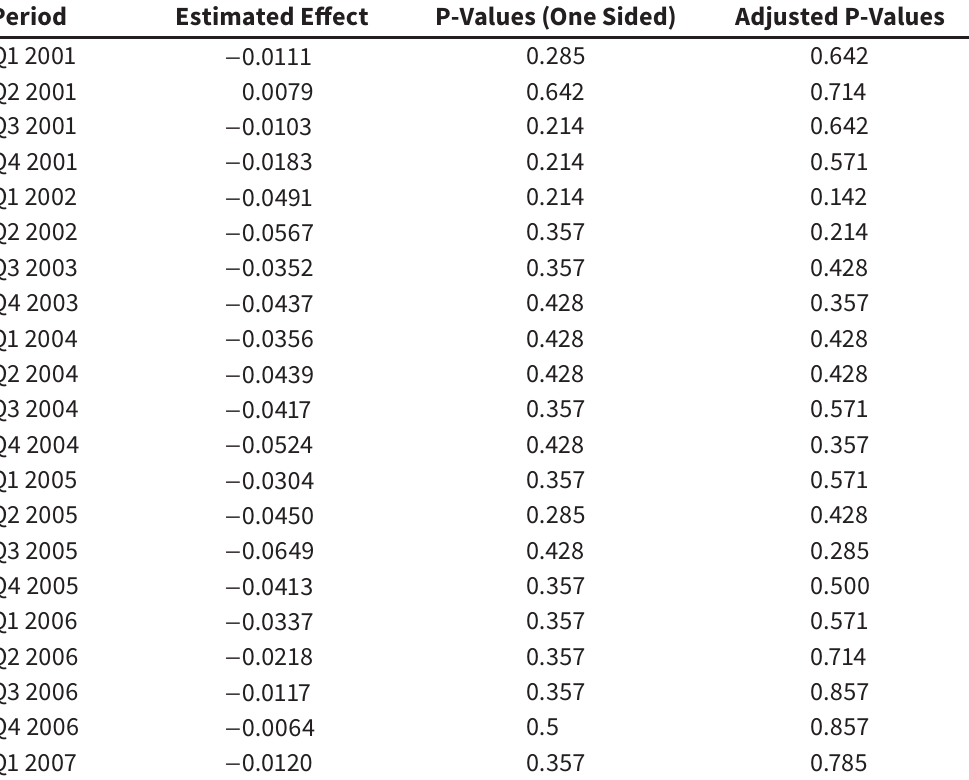
Treatment Effects and Significance for Log Employment in Puerto Rican Accom- modation and Food Industry (Placebo Treatment Date of Q4